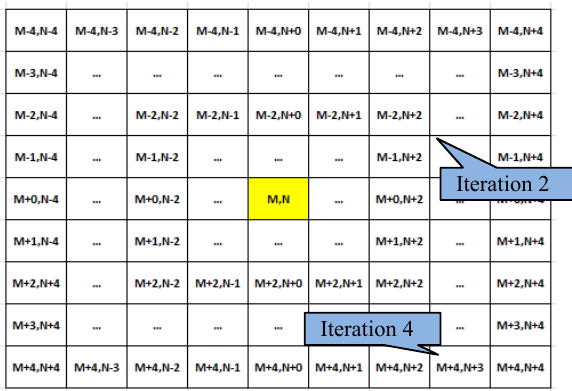
Figure 2. Schematic Representation of Neighborhood pixels of Pixel (M, N) for Iteration 2 and Iteration 4 At each iteration, the center pixel value in PALSAR is compared with searching pixel value and when it meets, the pixel that satisfy the condition as the below equation (3) (Hoan and Tateishi, 2008) and it is outside of cloud/shadow area in optical image, the searching is ended.